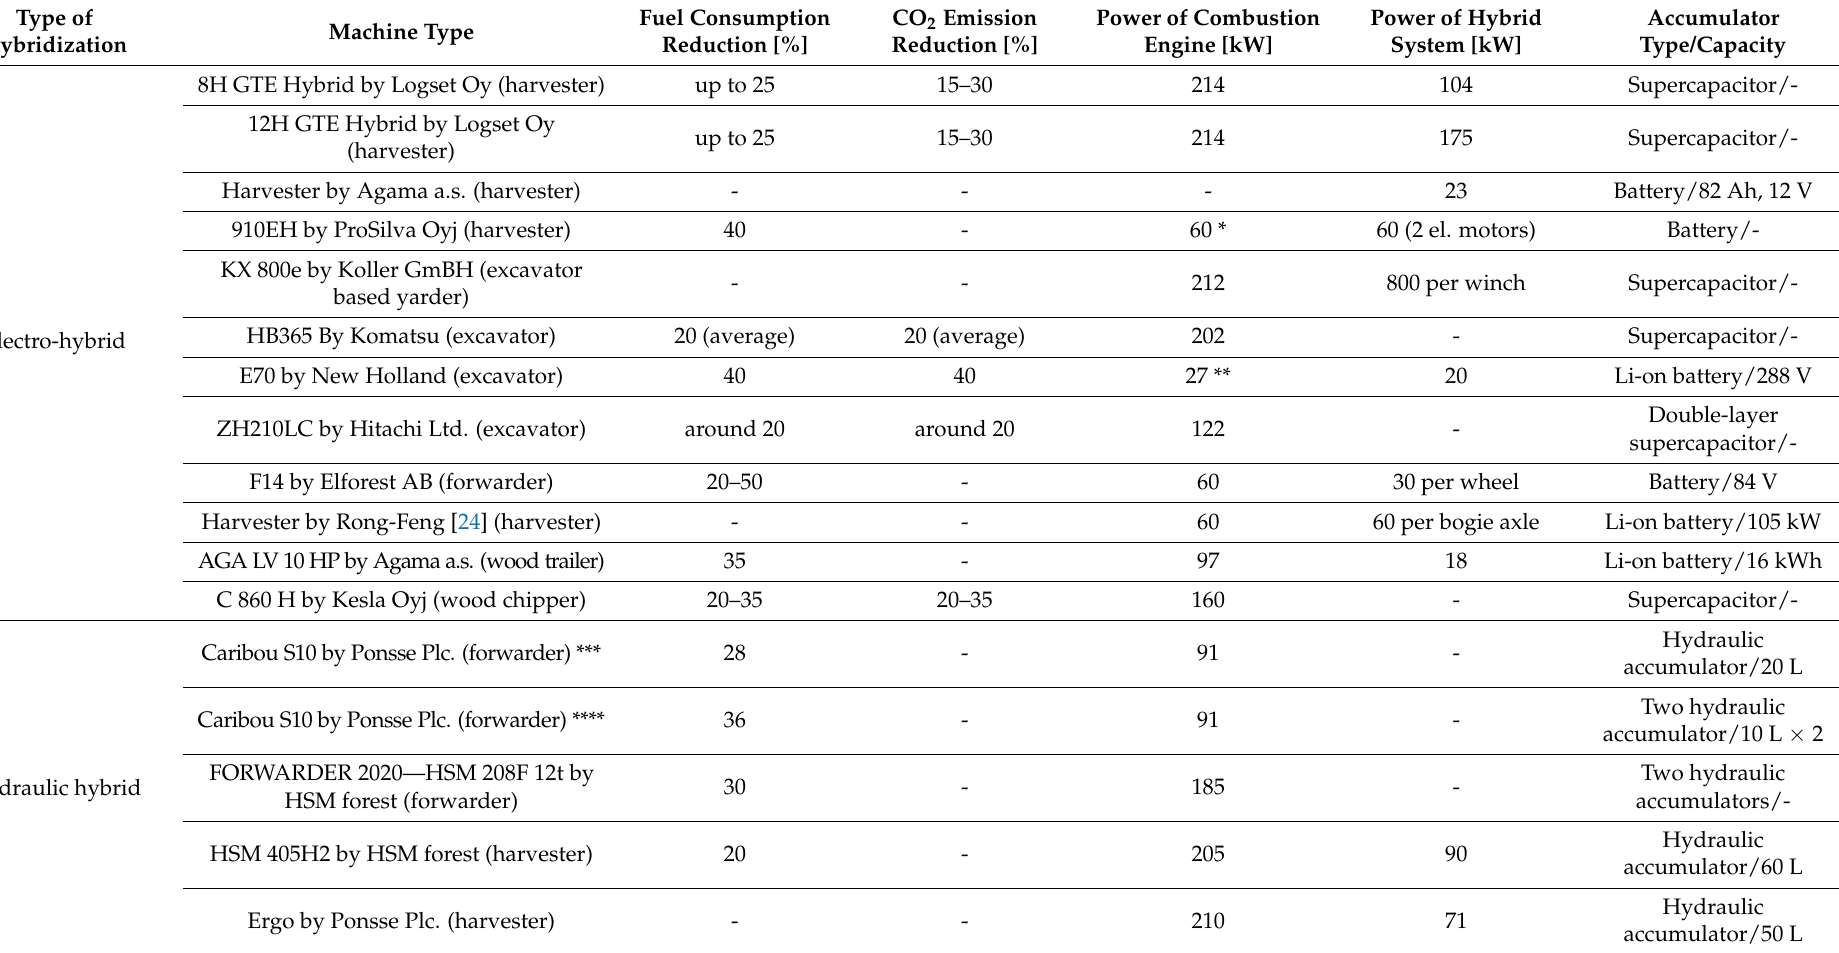
Table 1. Characteristics of hybrid forest